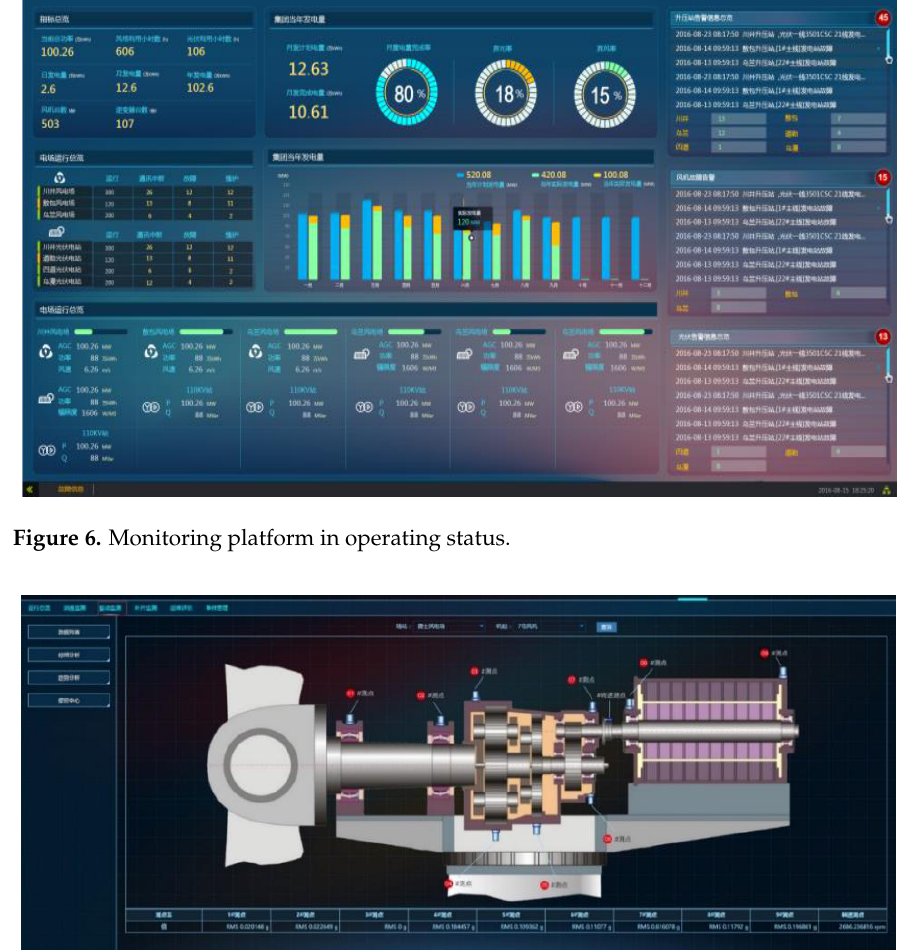
Figure 8. The output of gearbox broken tooth diagnosis model before and after gearbox tooth break of wind turbine A.